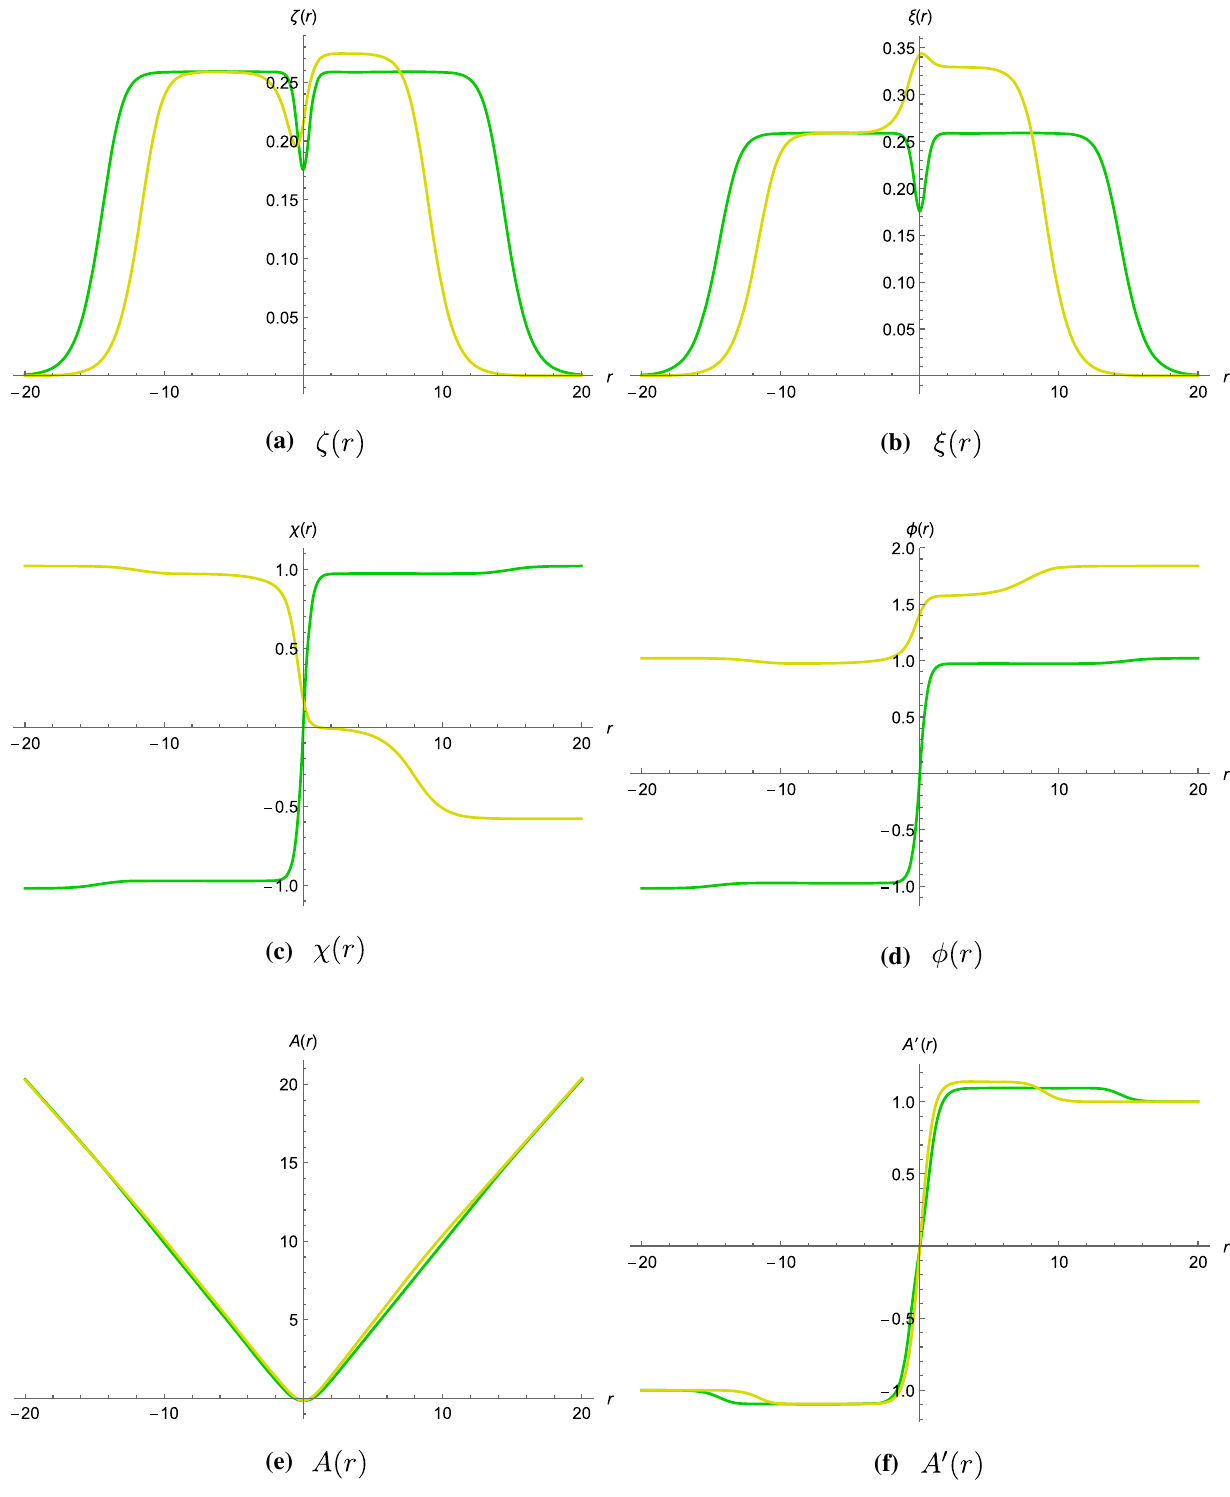
Fig. 4 Profiles of scalar fields (ζ,ξ,χ,φ) and the warped factor A for G 2 / G 2 and G 2 / U ( 3 ) Janus solutions as functions of the radial coordinate r are shown by green and yellow lines,